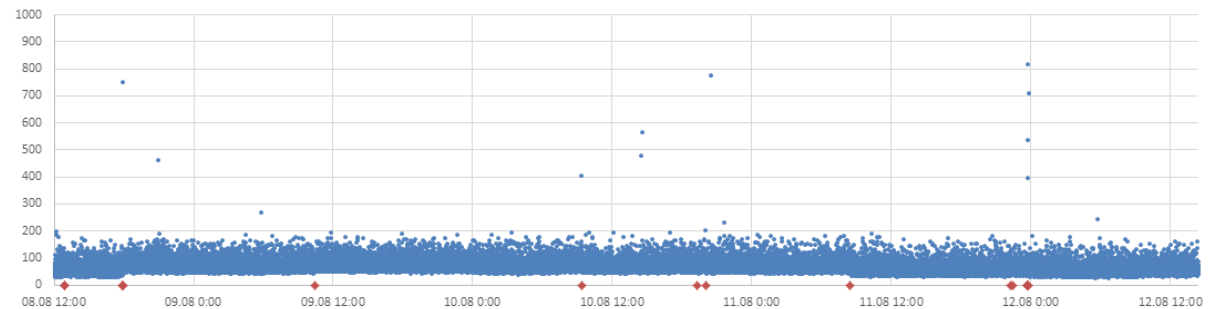
Fig. 9. RTT of lightly loaded LMT 3G first endpoint (RTU server), ms.